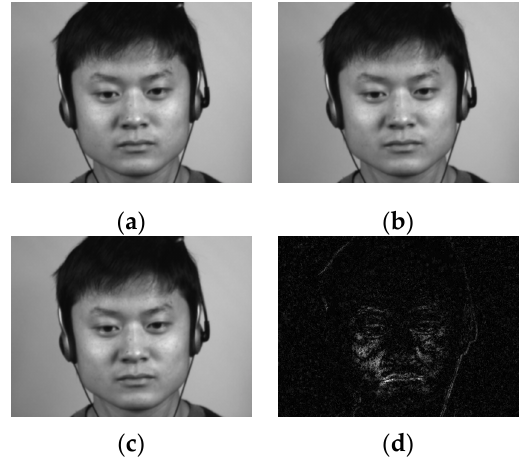
Figure 7. Frame differences for ME analysis: ( a ) frame f t − τ / 2 (the potential onset frame); ( b ) frame f t − ε (used for normalization); ( c ) current frame f t (the potential apex frame); and ( d ) movement magnitude variation (raw frames from CASME II database [12] (©Xiaolan Fu)). However, only 10 regions on the face are analyzed (Section 3.1). Therefore, for each cell c , the average value of the movement magnitude image ( µ c ( MM i )) within that region of interest is computed. For example, Figure 8 shows the variation of µ c ( MM i ) for the middle eyebrow cell during a ME sequence.